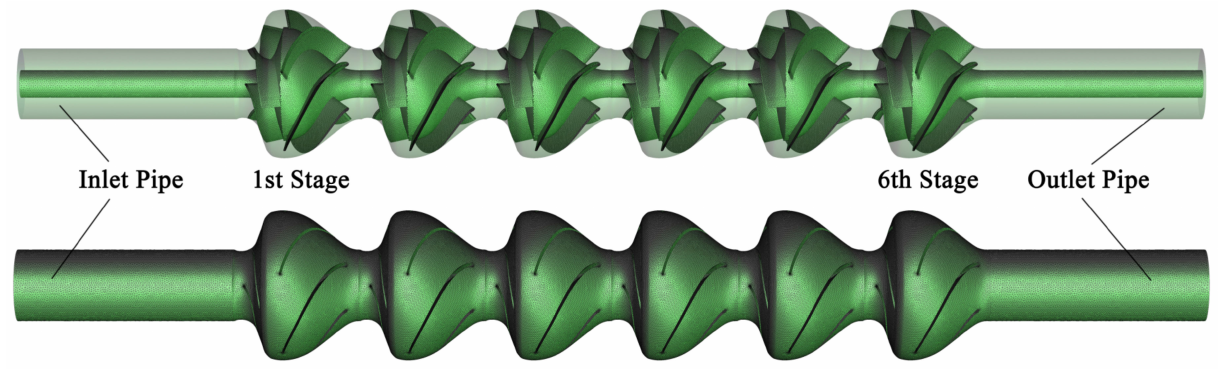
Figure 3. Meshes of the deep-sea mining pump.